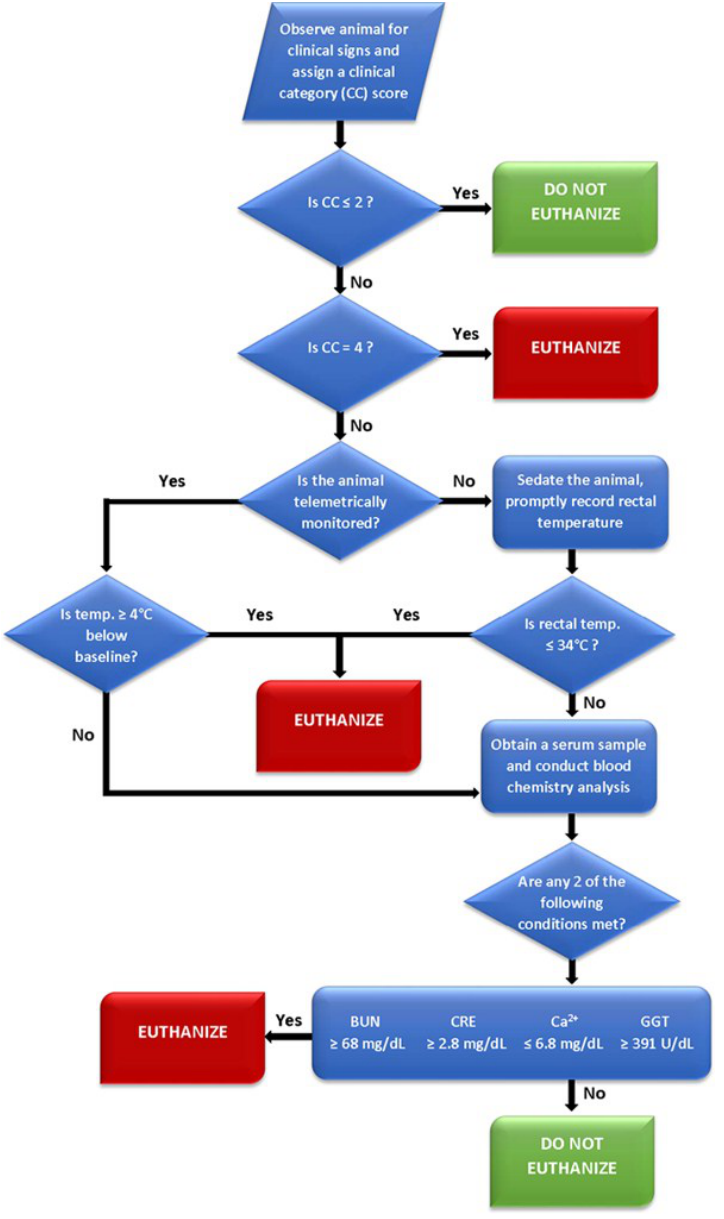
Figure 5. Flow diagram depicting a proposed euthanasia decision tree for Ebola virus infected rhesus